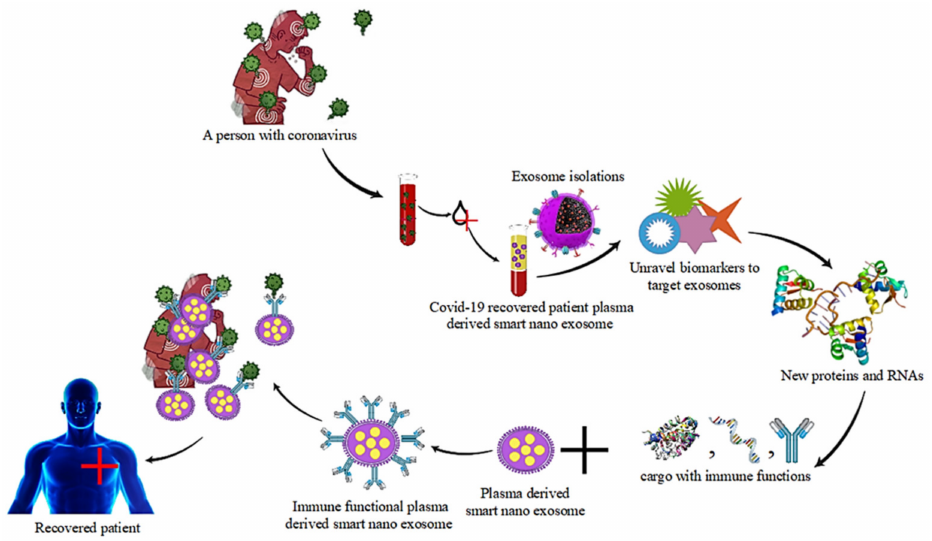
Figure 3. Recovery of a patient with coronavirus by plasma-derived smart